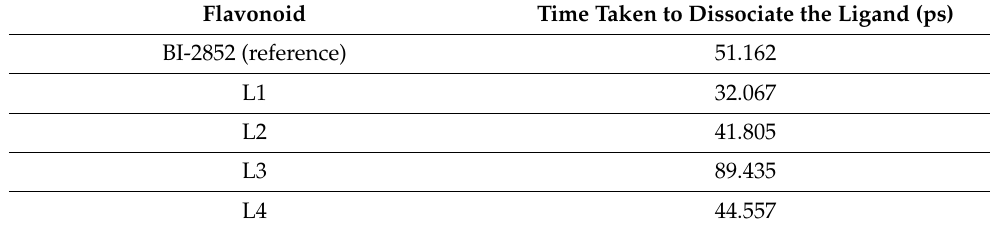
Table 6. Steered molecular dynamics of 4